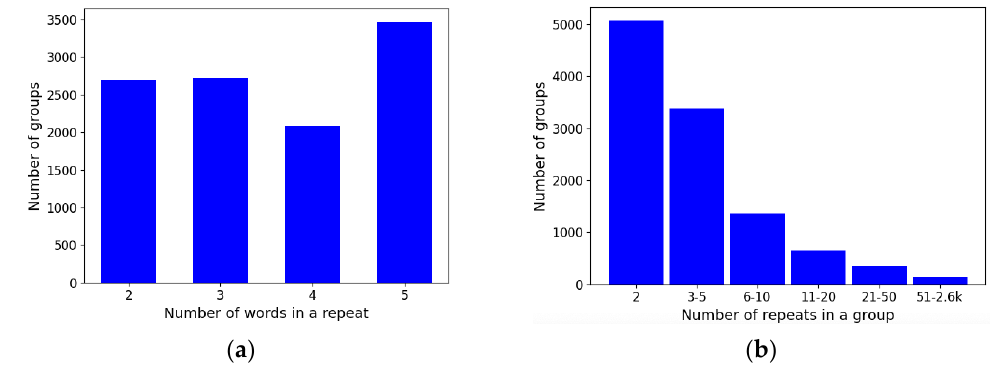
Figure 13. Bar charts with frequency statistics: ( a ) A bar chart with a number of groups with an equal number of words in a repeat; ( b ) A bar chart with a number of groups with an equal number of